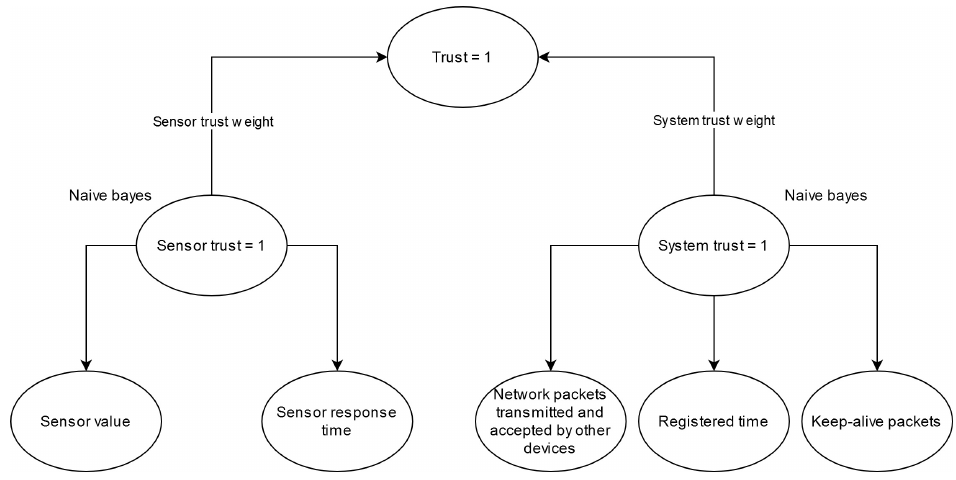
Figure 5. Naive Bayes reputation